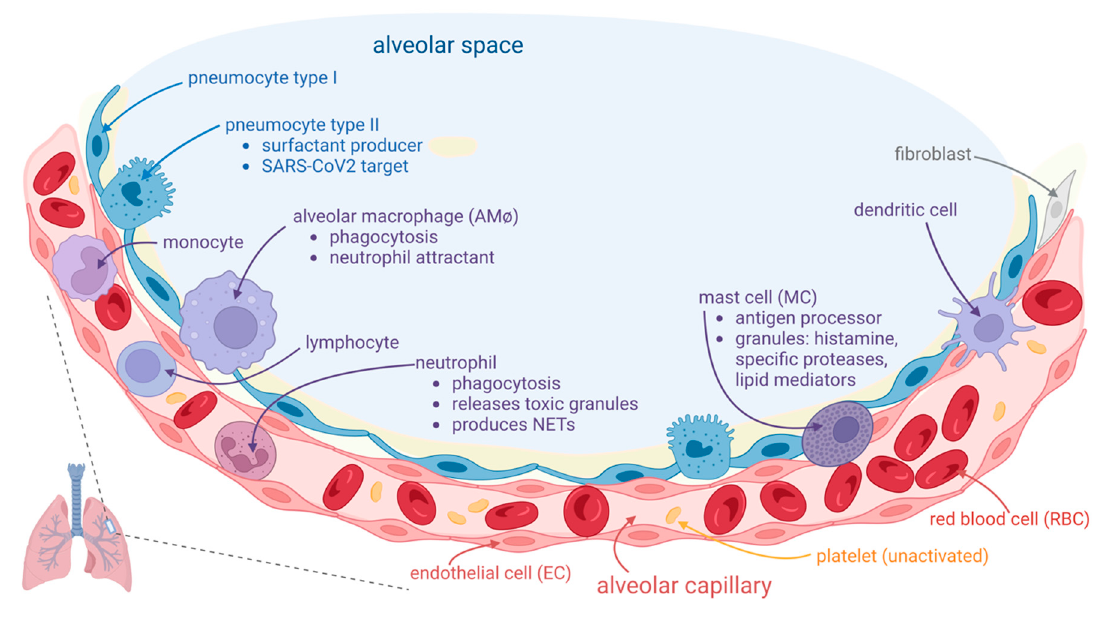
Figure 1. Normal host alveolar capillary associated immune defense system. The alveolar space is lined with alveolar epithelium, consisting of two kinds of cells: type I and type II pneumocyte; type II cells are involved in surfactant secretion (light yellow in the figure) and in local innate immune defense. They are also a target for SARS-CoV-2, which replicates inside these cells and can be further transferred into adjacent endothelial cells (ECs). The alveolar macrophages (AM ϕ s) are placed into alveolar space, adjacent to the alveolar epithelium. AM ϕ s are largely involved in immune defense, mainly by two processes: phagocytosis and chemoattraction of neutrophils. The alveolar-capillary layer is very thin over a large area, consisting of the adjacent membranes of both respiratory epithelium and vascular endothelium, and it is thicker where the body of these cells and other cells (fibroblasts in interstitium, mast cells (MCs) in subendothelial place) or other interstitial elements are placed. MCs are involved in COVID-19 pathogenicity. They contain granules with histamine and specific proteases. The capillary, lined with flat ECs, contains red blood cells (RBCs), platelets, and white blood cells. Neutrophils could pass into alveolar space if they are chemoattracted by activated AM ϕ s. They are involved in the phagocytosis process. They contain granules with oxidants, that could be released outside the cell. They also can release extracellular traps (NETs) consisting of web-like structures containing DNA filaments coated with histones and granule proteins that can entrap and eliminate various pathogens.